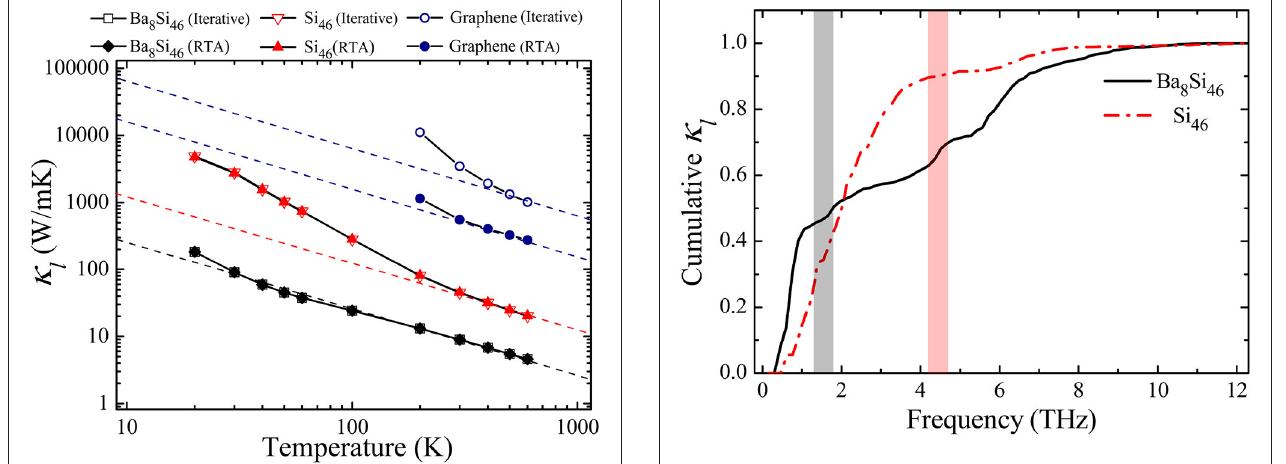
FIGURE 4 | Normalized accumulative thermal conductivities for Ba 8 Si 46 (solid line) and Si 46 (dash-dot line) at room temperature. The shadowed regions highlight the upper bound of acoustic branches for Ba 8 Si 46 (black) and Si 46 (red),